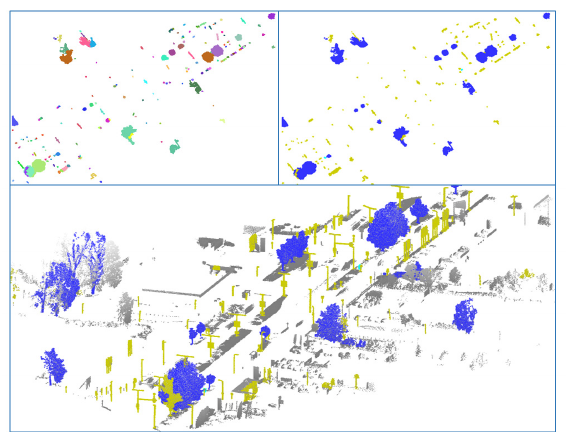
Figure 9. Object segmentation of dataset 2 after the fusion with map points: segmentation (top left), classification (top right), overlaid on the non-ground MLS data (bottom).